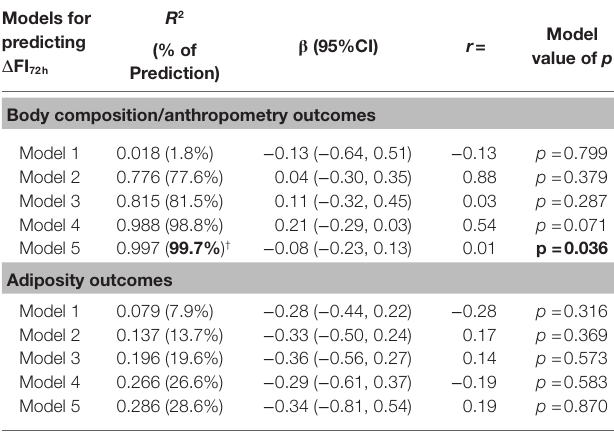
TABLE 3 | Body composition/anthropometric and adiposity outcomes (delta changes) predicting the changes in fasting plasma glucose from post-24 h to post-72 h in participants after 12-weeks of concurrent training.